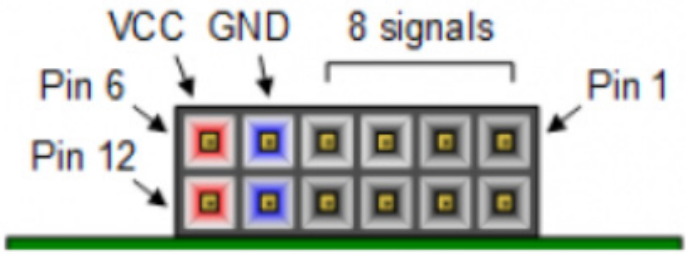
Figure 14. Pmod connectors. Front view. Table 3. Nexys4 DDR Pmod pin assignments.